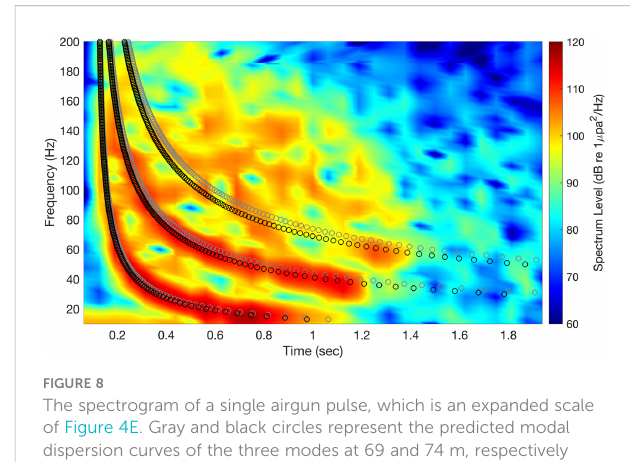
FIGURE 8 The spectrogram of a single airgun pulse, which is an expanded scale of Figure 4E. Gray and black circles represent the predicted modal dispersion curves of the three modes at 69 and 74 m, respectively (which are layer-2 depths at the source and receiver